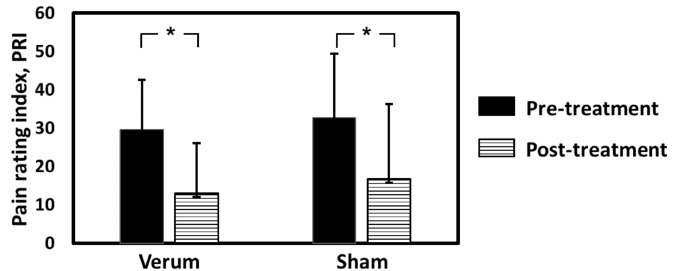
Figure 1. Total pain rating index from McGill Pain Questionnaire before and after acupuncture treatments. * p < 0.05.